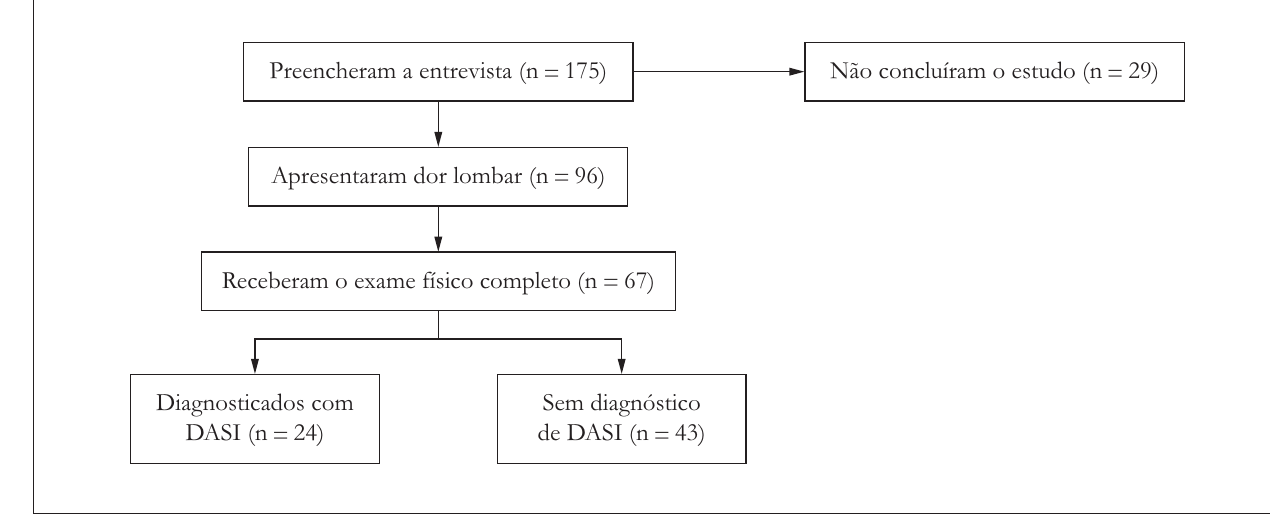
Figura 1 - Fluxograma apresentando as fases do estudo e o número de participantes. DASI= Disfunção da articulação